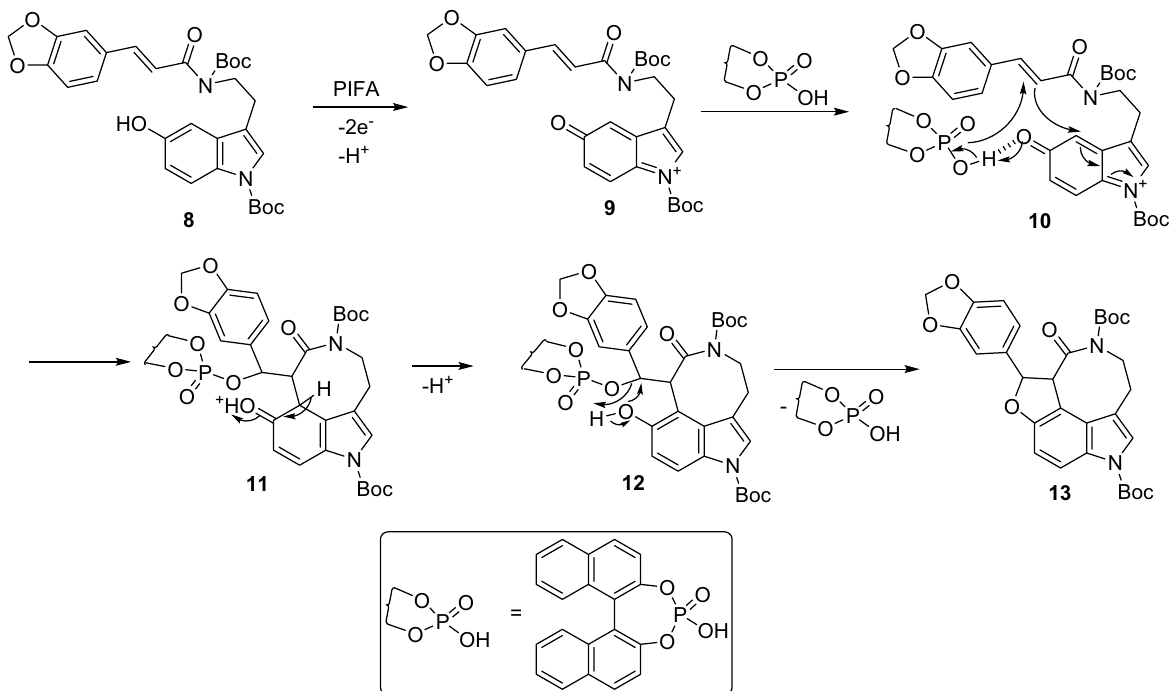
Figure 5. Proposed mechanism of tandem oxidative cyclization.